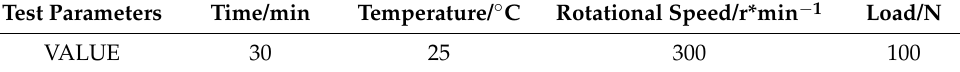
Table 5. Friction and wear test parameters.